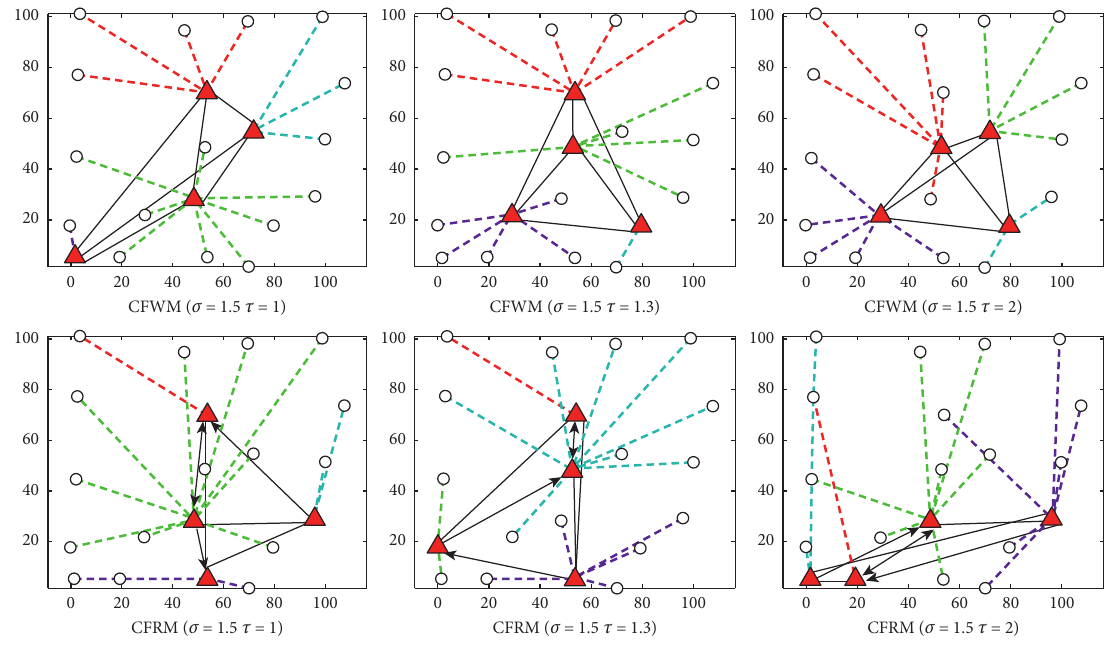
Figure 7: Impact of parameter τ on network